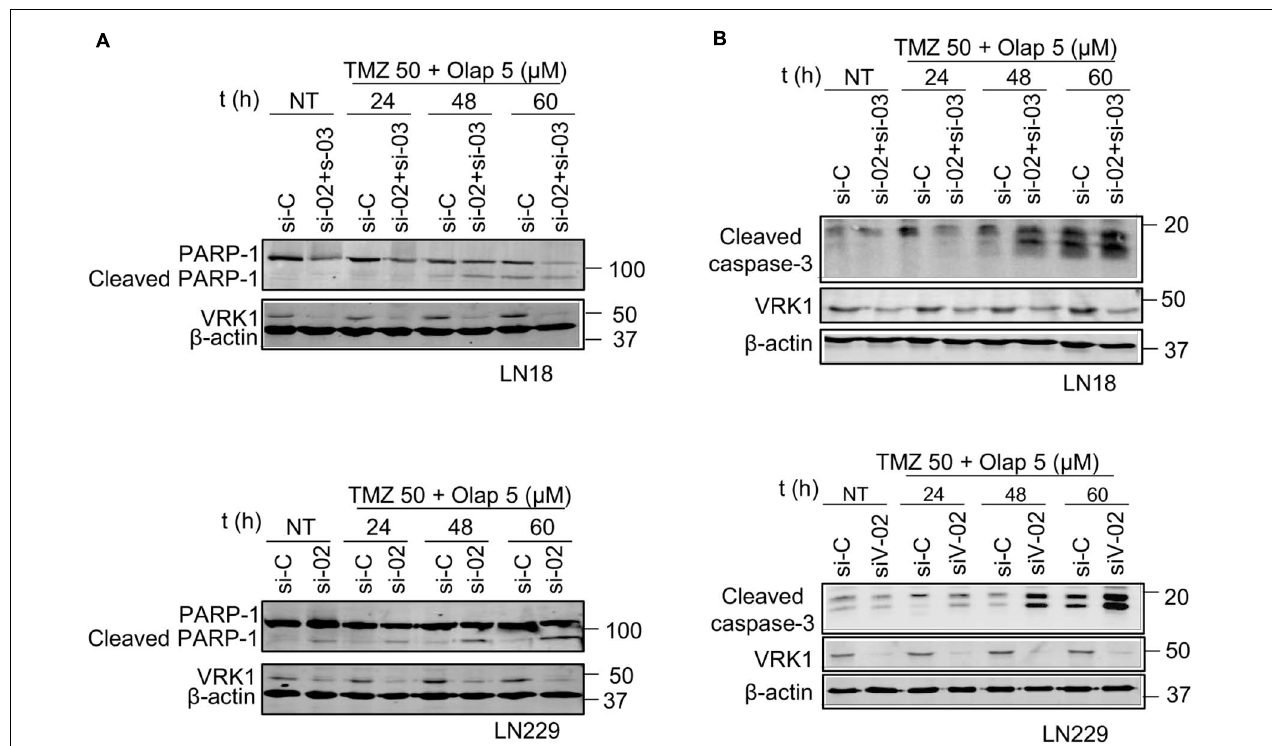
FIGURE 7 | Effect of VRK1 knockdown on cell death induced by TMZ and olaparib treatments in LN-18 and LN-229. (A) Effect of the combination of VRK1 depletion by siVRK1-02 and siVRK1-03 on PARP1 after TMZ, olaparib and the combination of both drugs. Western blot showing total protein levels of full-length PARP1 (116 kDa) and cleaved PARP1 (86 kDa) in LN-18 (top) and LN-229 (bottom). (B) Effect of the combination of VRK1 depletion by siVRK1-02 and siVRK1-03 on caspase-3 processing. Western blot showing total protein levels of cleaved caspase-3 in LN-18 (top) and LN-229 (bottom). Cleaved PARP1 and cleaved caspase-3 were used as markers of caspase activation. β -actin was used as load